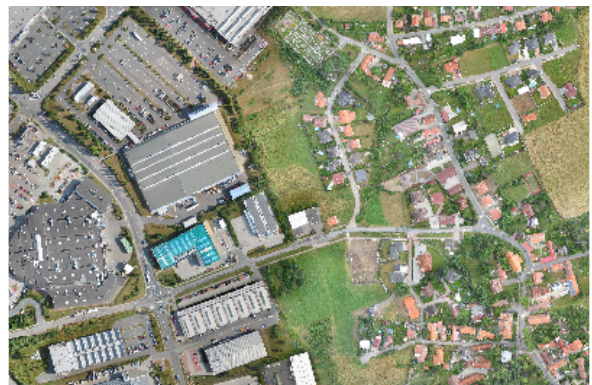
Figure 4: Final true orthophoto image